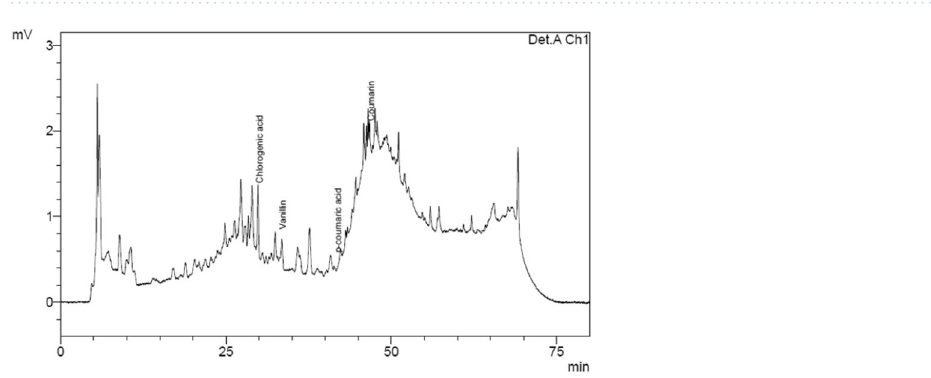
Figure 5. Correlation between VHP sugar color and: ( a ) total phenols; ( b ) total polyphenol content; ( c ) chlorogenic acid; ( d ) vanillin; ( e ) p -coumaric acid; ( f ) coumarin.